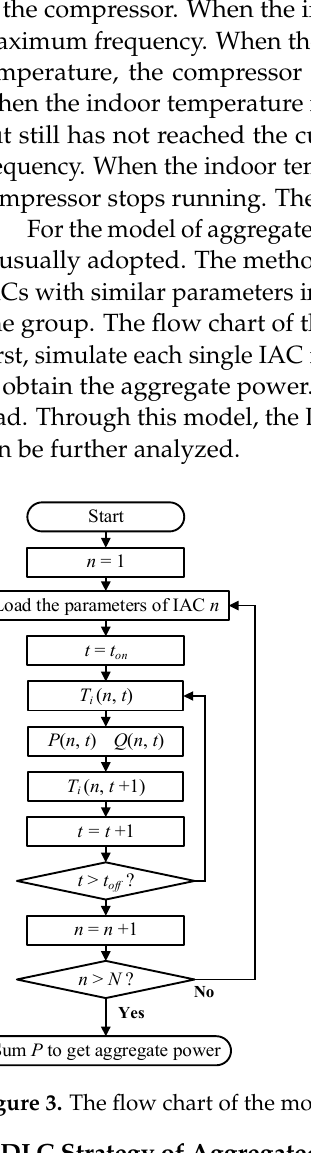
Figure 3. The flow chart of the model of aggregated IAC